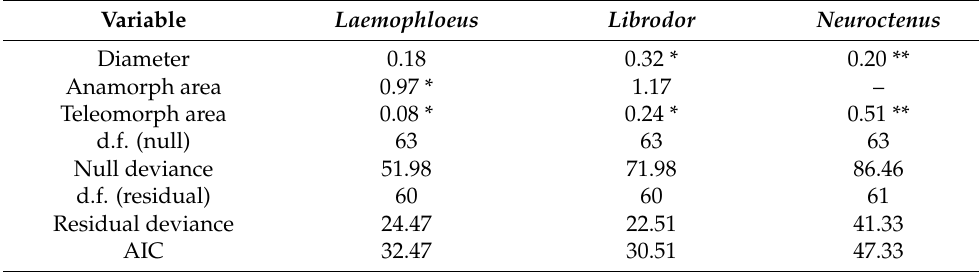
Figure 4. Frequencies of Laemophloeus submonilis ( a ), Librodor ipsoides ( b ), and Neuroctenus castaneus ( c ) on Quercus serrata logs. Grey and white bars show the top and bottom sides of the logs, respectively. Table 2. GLM results showing estimated coefficients between occurrences of the three dominant insect species and log variables.